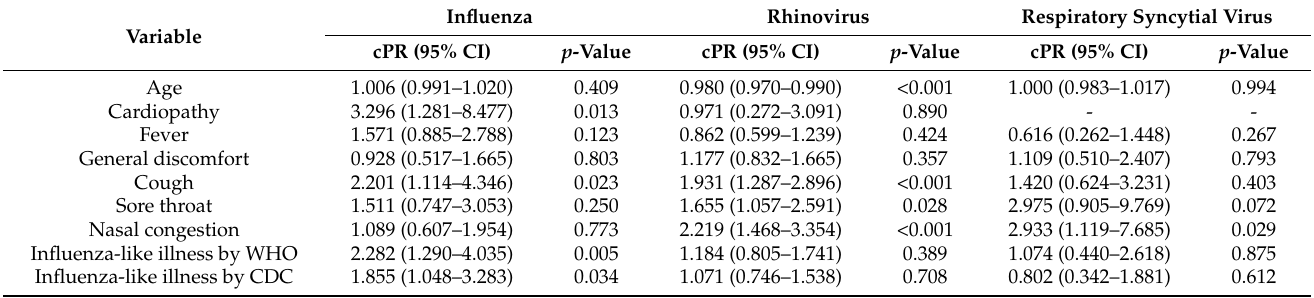
Table 3. Main clinical characteristics in relation to the pathogens detected. This table shows the Poisson regression analysis to evaluate crude prevalence ratio of respiratory